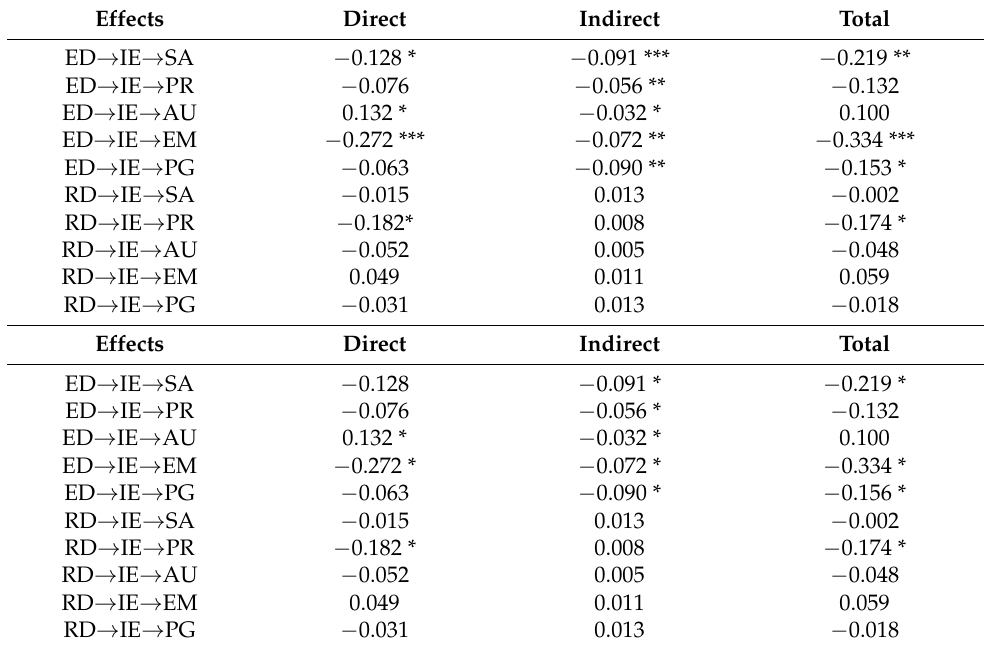
Table 2. Standardized indirect and total effects of the mediation